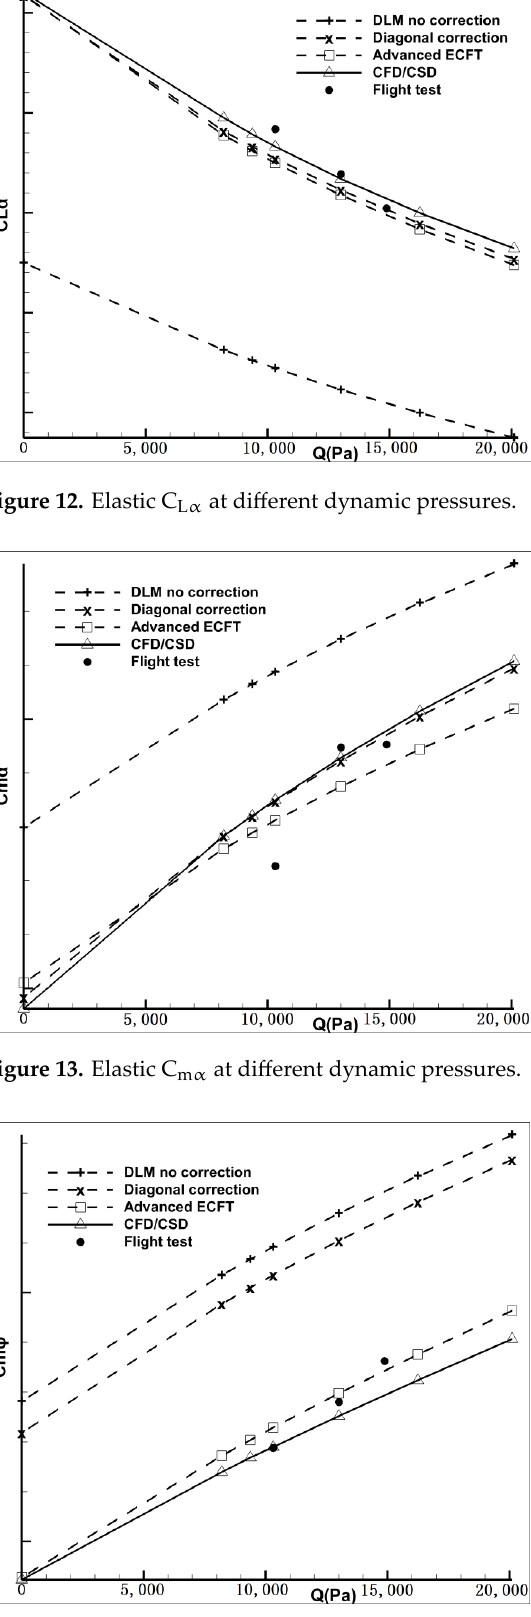
15 of 18 Figure 11. Elastic Δ Cp for a unit ϕ in the horizo ntal tail, fuselage, and nacelle component. 3.3. Elastic Aerodynamic Derivative at Different Dynamic Pressure